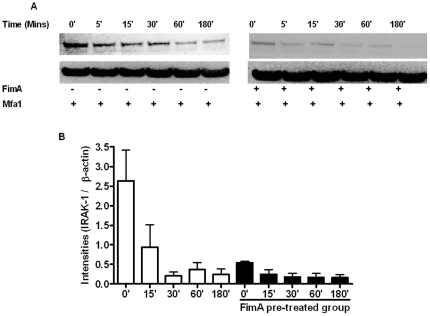
FimA induced tolerance is IRAK-1-mediated.Human PBMCs were pre-treated (B) or not (A) with 1 µg/ml rFimA for 24 hrs before stimulation with 1 µg/ml of rMfa1 for various timepoints. Immunoblots (30 µg protein per well) were probed for IRAK-1 and subsequently re-probed for IκBα and β-actin. (C) Mean (s.e.) normalized band intensities.